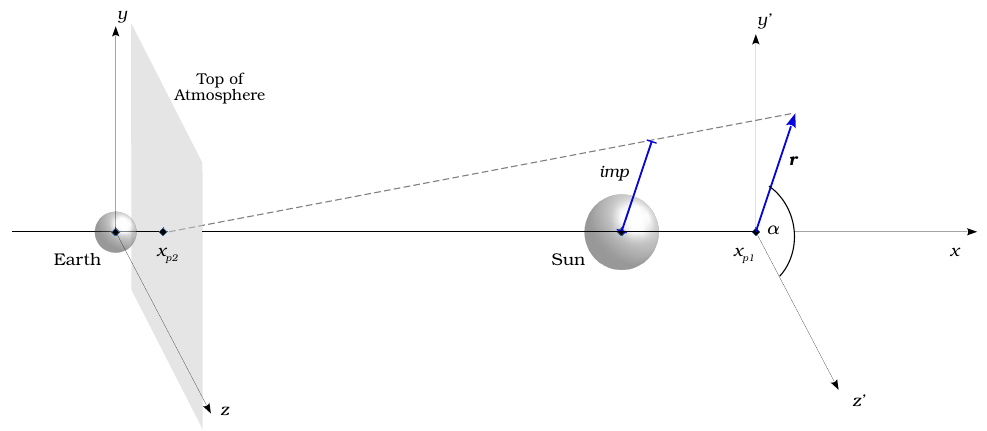
Figure 1. The coordinate system used in the previous version of the PRESHOWER simulator. The dashed line shows the primary photon trajectory, x p 1 —the fixed x coordinate of the simulation starting point; the distance between x p 1 and the Sun’s centre is 10 R (cid:12) . The imp (blue line) is the impact parameter (the input simulation parameter) and the blue vector r , which lies in the y (cid:48) z (cid:48) plane, points at the simulation starting point. The angle α between the r and the z axis is the heliocentric latitude (the simulation input parameter), while the vector length | r | = r _ at _ beginning is a parameter calculated during the simulation. The x p 2 point determines the top of the atmosphere plane x = x p 2 and it is the arrival point of the primary